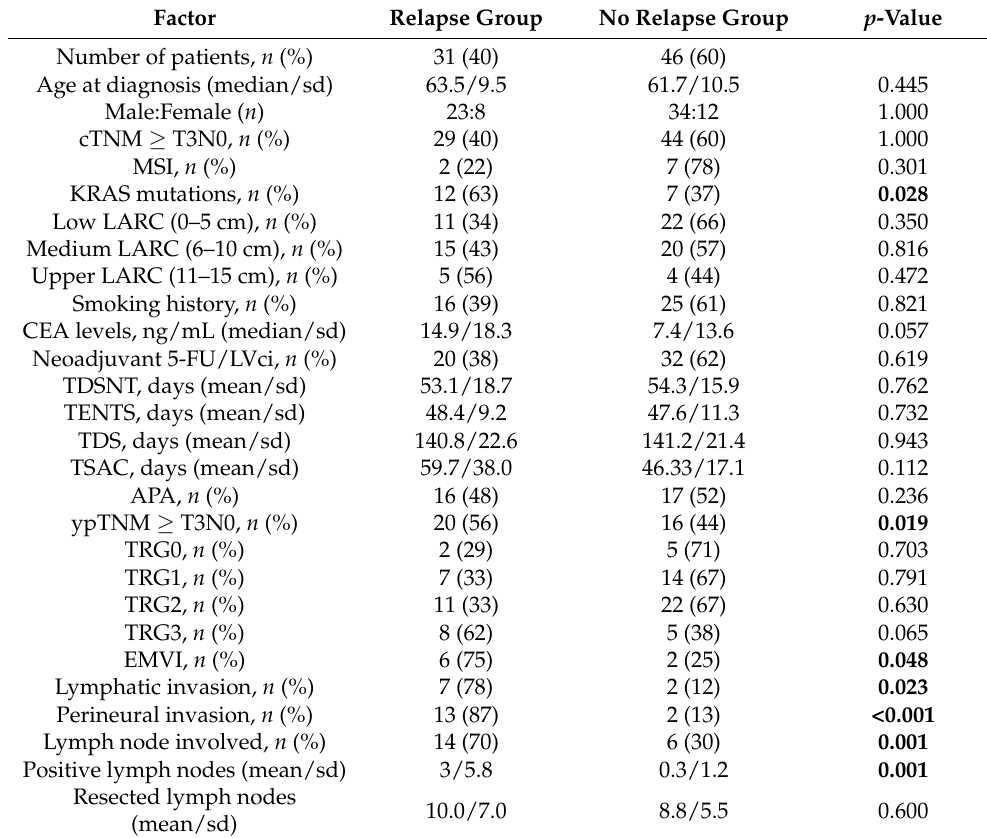
Table 1. Univariate analysis comparing